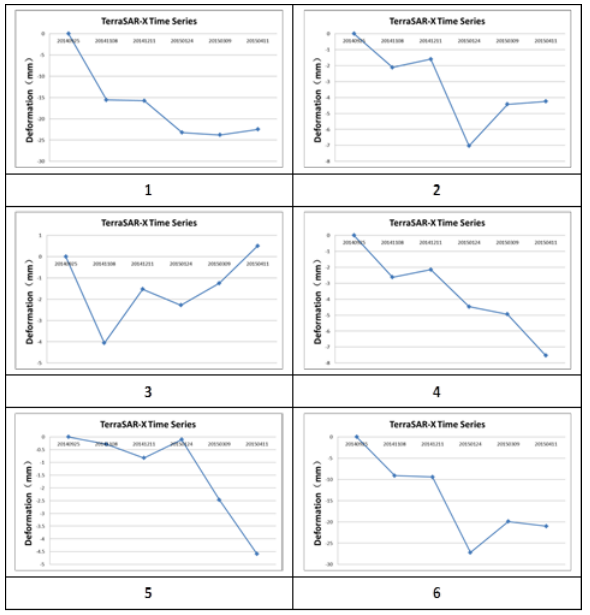
Figure 7. the time series plot of PS point as samples(total 6 PS